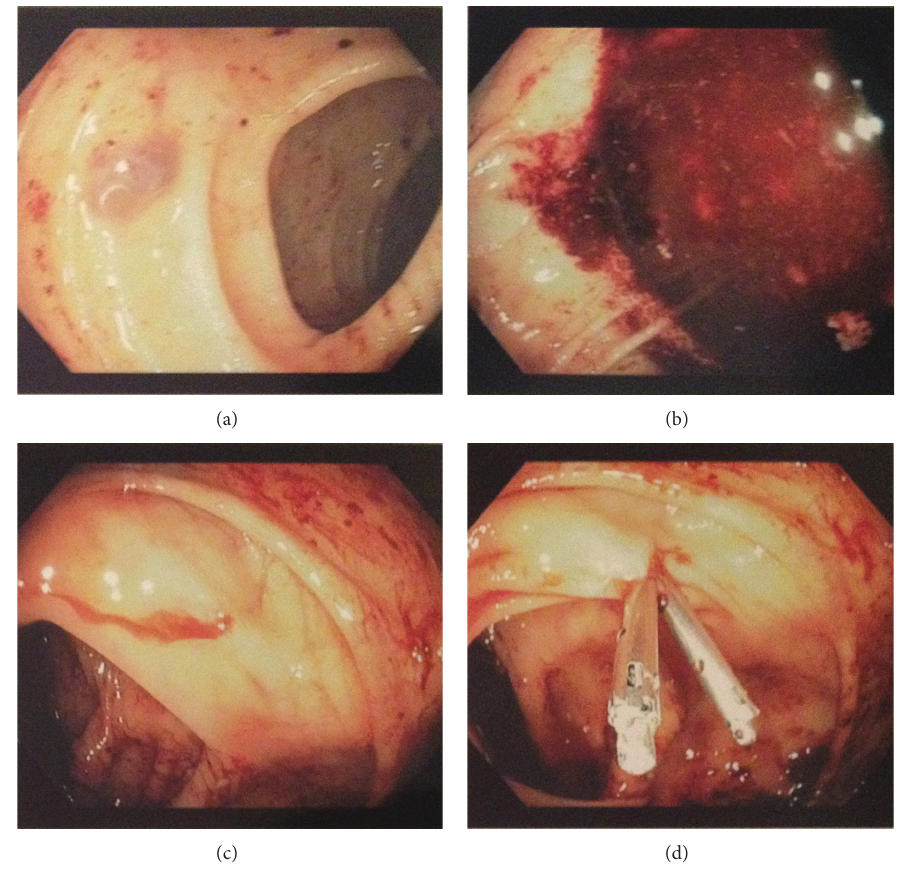
Figure 1: Procedure: Olympus colonoscope was advanced from the anus under direct visualization to the cecum. Cecum was confirmed by appendiceal orifice and ileocecal valve. There was large amount of clots and blood throughout the colon, and there was active bleeding from the proximal ascending colon. After irrigation it appeared to be from a Dieulafoy lesion at the proximal ascending colon with active bleeding. Two endoclips were placed with excellent hemostasis. It was decided not to use cautery due to the patient’s thrombocytopenia. Due to the presence of large amount of old blood and clots throughout the colon, polyps cannot be ruled out, so this procedure was not optimal for screening purposes. The patient tolerated the procedure very well and there was no immediate complication associated with the